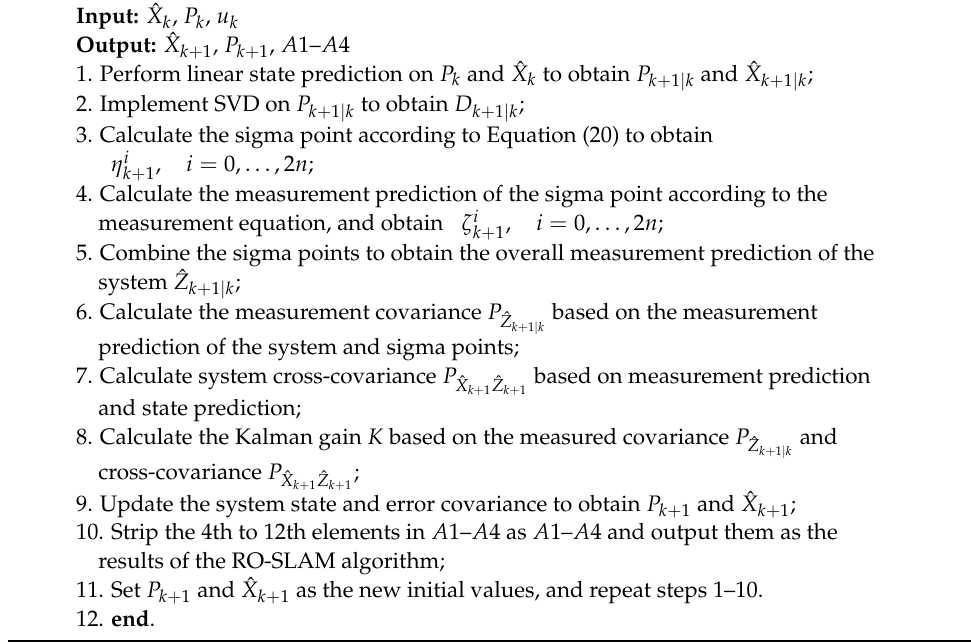
Algorithm 1: Detailed steps of the range-only 3D RO-SLAM based on SVD-DUKF.